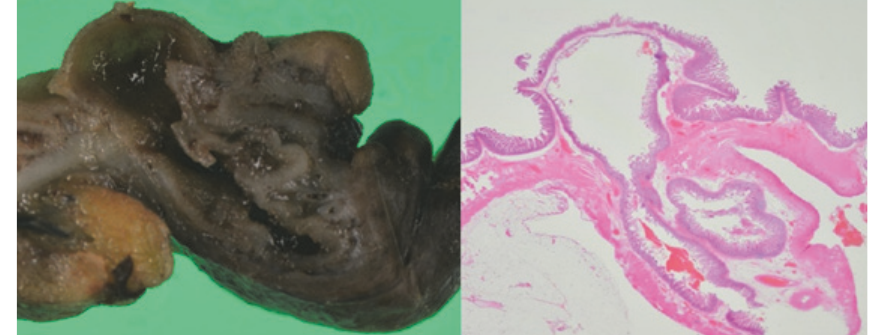
Figure 5: One of the cysts showed fistulation with submucosal layer of small intestine. Communicating with the lumen was not apparent.